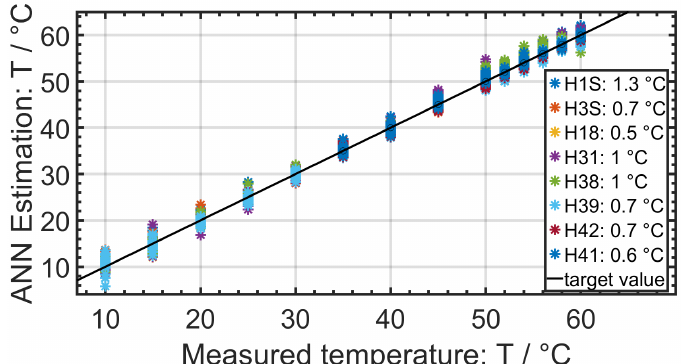
Figure 7. More than 4000 temperature estimations by a neural network using EIS data as input are presented. The estimated temperature is plotted over the measured temperature. The black line is a guide to the eye for the target values. The overall RMSE for 8 Samsung INR18650-15L1 cells was less than 1 K. The legend shows the RMSE for each